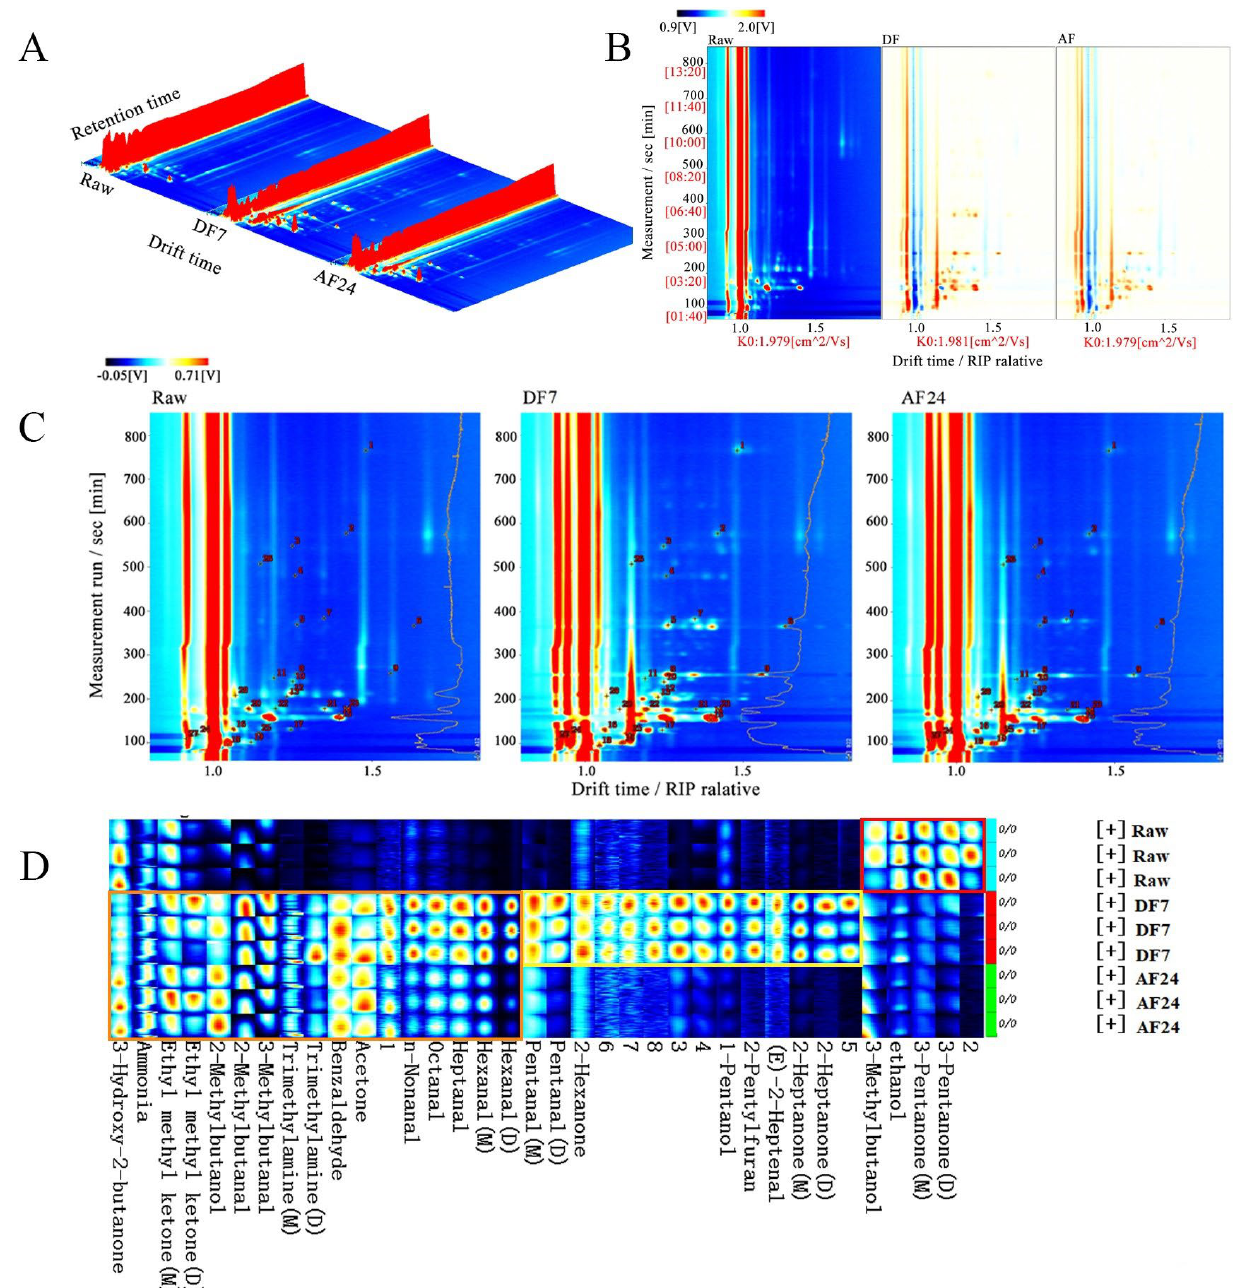
Figure 4. ( A ) Three-dimensional topographic of VOCs. ( B ) Comparison of the difference spectrum of volatile components. ( C ) Qualitative spectrum of volatile components. ( D ) Fingerprint comparison of volatile organic compounds (VOCs) of hairtail fillets in different frying methods determined by HS-GC-IMS. Raw, untreated; DF7, deep frying for 7 min; AF24, air frying for 24 min; Raw, untreated; DF7, deep frying for 7 min; AF24, air frying for 24 min.